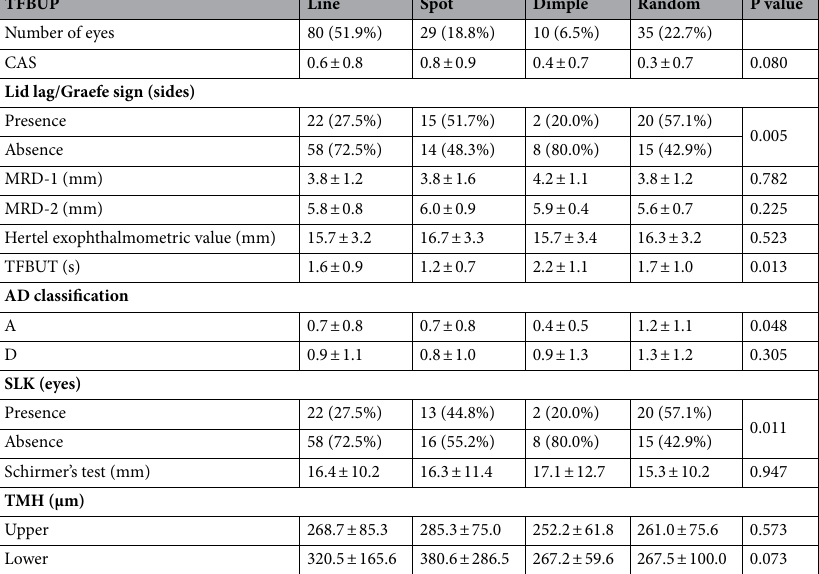
Table 2. Comparison of the results among the tear film break-up pattern (TFBUP) groups. CAS clinical activity score, MRD margin reflex distance, TFBUT tear film break-up time, SLK superior limbic keratoconjunctivitis, TMH tear meniscus height.